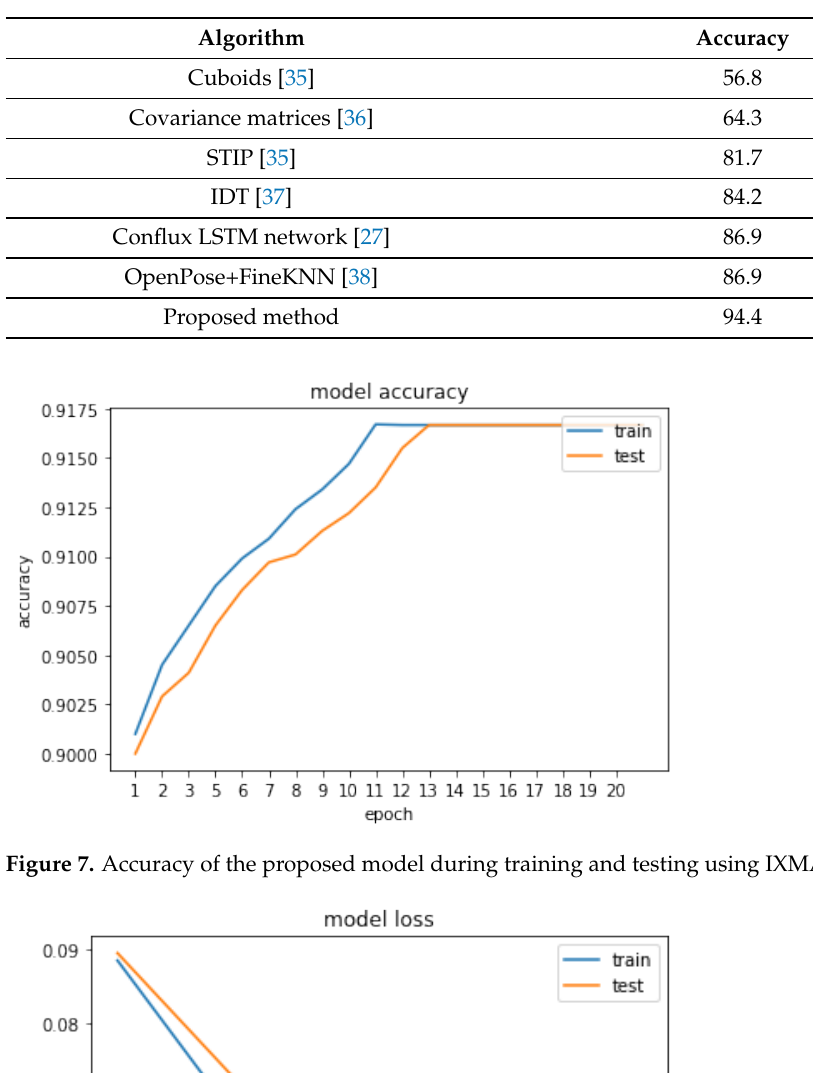
Table 5. Multi-view HAR on MCAD dataset.